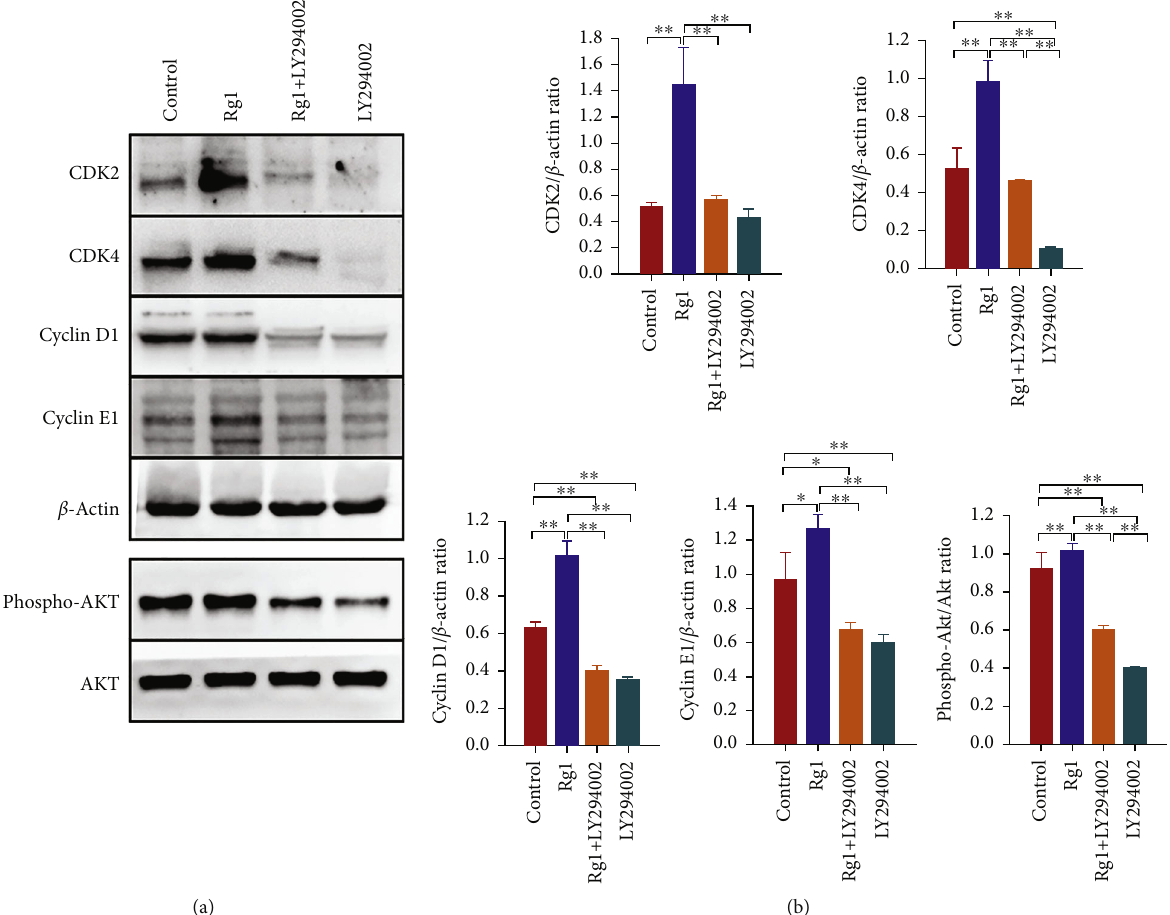
Figure 3: E ff ects of ginsenoside Rg1 on the PI3K/AKT signaling pathway and expressions of cyclins and CDKs in hAD-MSCs. (a, b) The expressions of Akt, phospho-Akt, cyclin D1, cyclin E1, CDK2, and CDK4 in hAD-MSCs were analyzed (a) and compared (b) by western blot after pretreatment of hAD-MSCs with or without LY294002 for 1 h followed by the treatment with or without Rg1 in the control, Rg1, Rg1 +LY294002, and LY294002 groups. ∗ P < 0 : 05 and ∗∗ P < 0 : 01